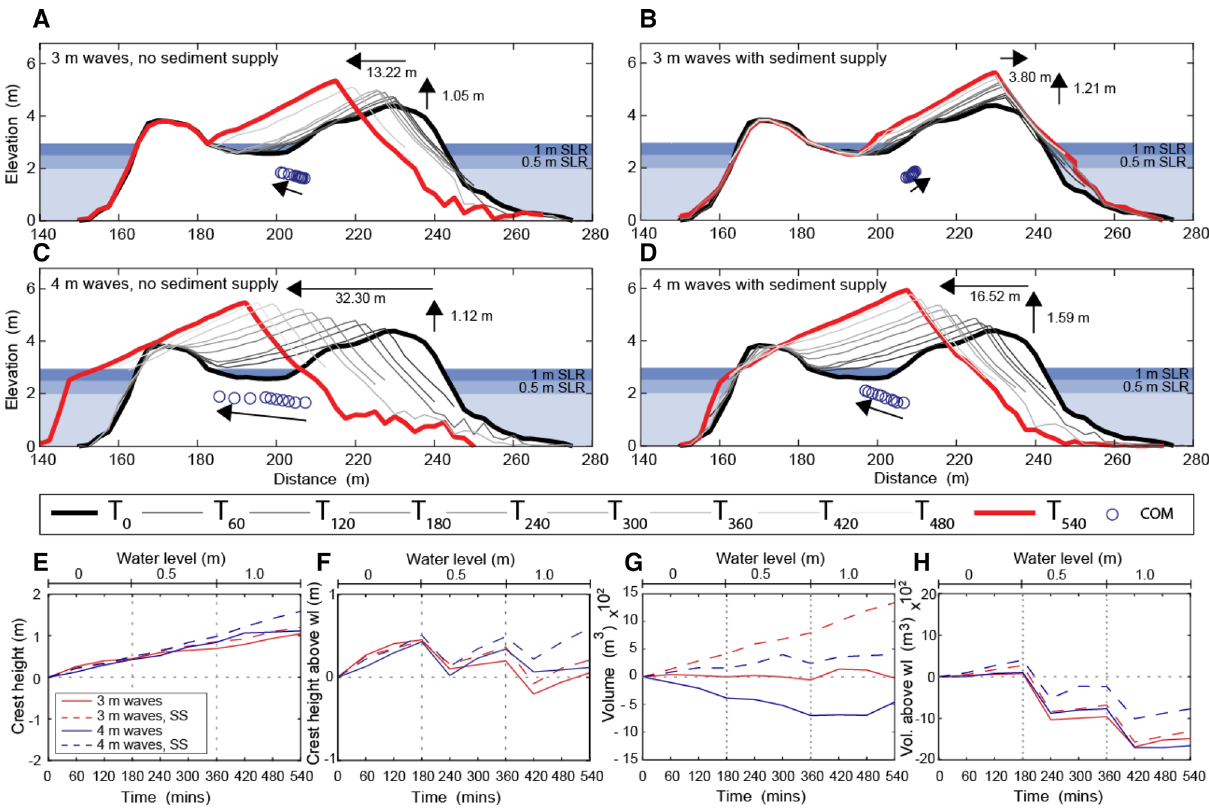
Figure 1. Results of flume experiments with 0 m (0–180 min), 0.5 m (180–360 min) and 1.0 m (360–540 min) SLR under 3 m ( A , B ) and 4 m ( C , D ) wave conditions without and with sediment supplied to the island, respectively. Circles show displacement of the islands center of mass (the net outcome of both horizontal and vertical island adjustments) across the simulations. Values of vertical accretion and shoreline lateral displacement during each experiment are depicted in A-D. Changes in crest height ( E ), crest height above wl ( F ), Island volume ( G ) and Island volume above wl (H) across the simulations is